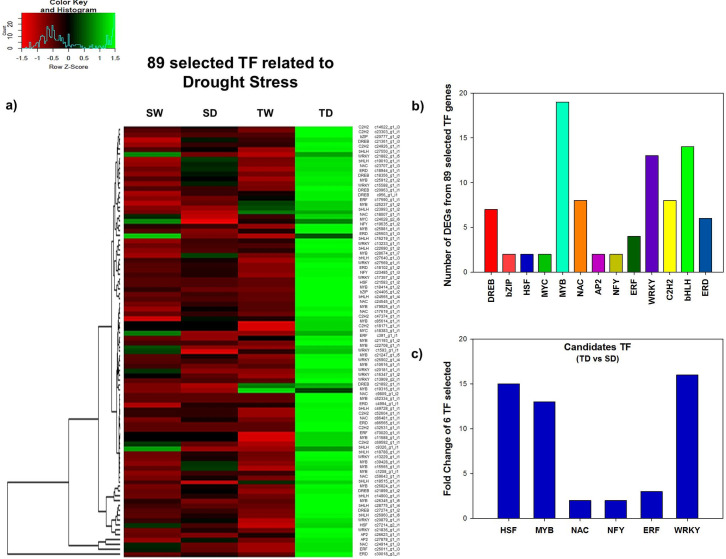
DEGs analysis of 89 TF genes related to drought stress, selected according to their high number of transcripts per million (TPM) and high fold change rate.Hierarchical clustering of 89 TF genes identified in the papaya transcriptome, based on the ratio between SD/TD, with fold change rates greater than 1.5 (p < 0.001). Red indicates down-regulated, green indicates up-regulated and black unchanged values, as shown on the color scale at the side of the figure a). Distribution by TF family of the number of DEGs from the 89 selected TF genes b). Fold Change of TF candidate genes selected, according to the ratio between SD/TD, to be validated by RT-qPCR c).